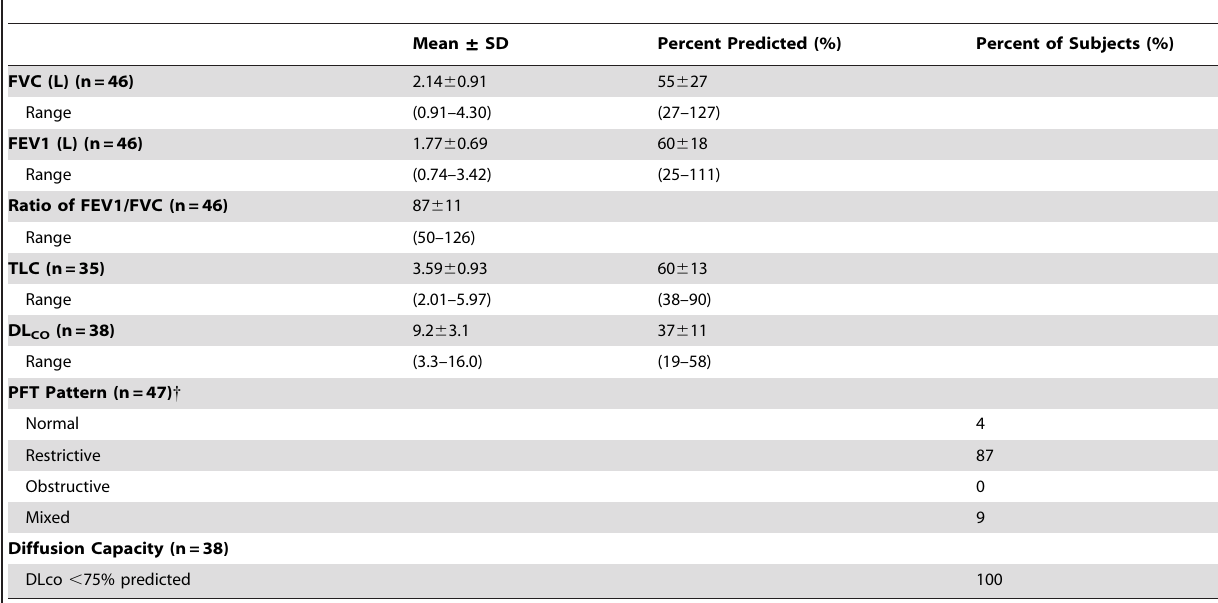
Table 3. Pulmonary function tests of TERT mutation carriers with pulmonary fibrosis.